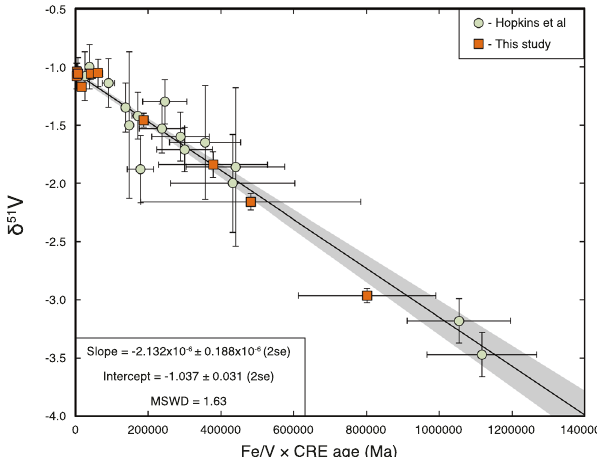
Fig. 1 Vanadium isotope compositions of lunar samples plotted against their Fe/V-scaled CRE ages. In this study, Fe/V ratios of all samples were measured on minor splits of the dissolved samples that were processed for V isotope measurements. The best- fi t line and gray 2SE envelope through all the data, calculated by taking into account 2SE errors in both x and y, has a y-intercept of δ 51 V Moon = − 1.037 ± 0.031 (2SE). This value represents our best estimate for the irradiation free V isotope composition of the Moon. Orange squares are from this study, green circles from ref. 16